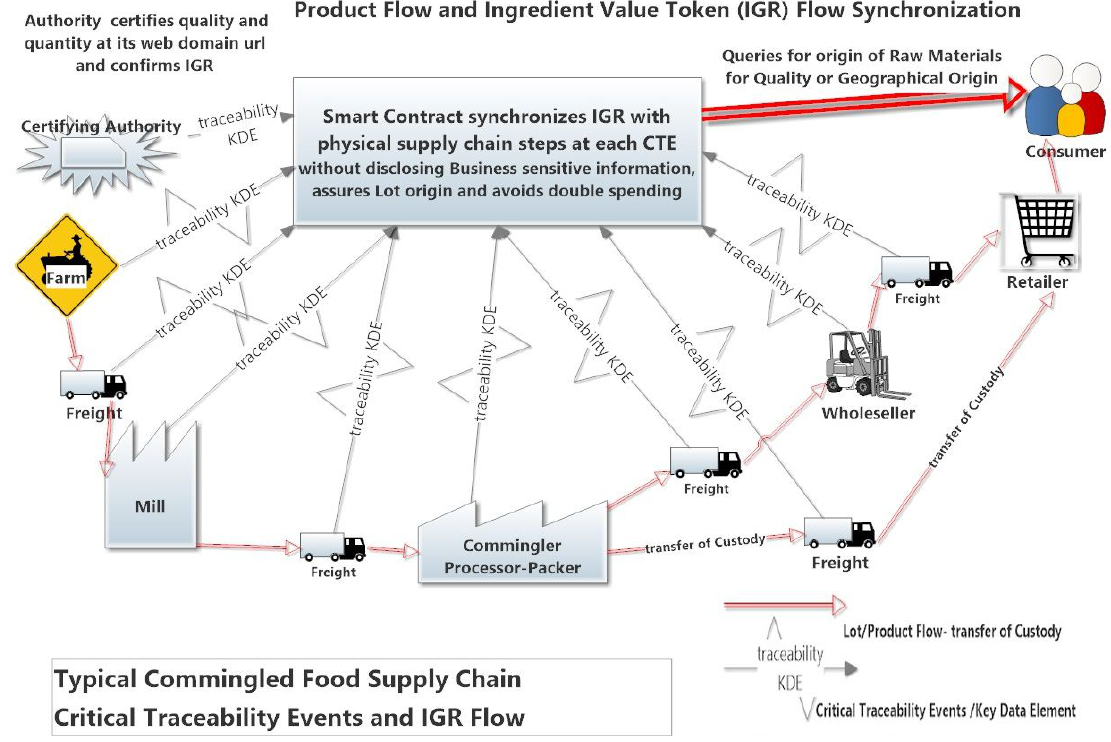
Figure 5. Synchronization of Food Lots and their IGR